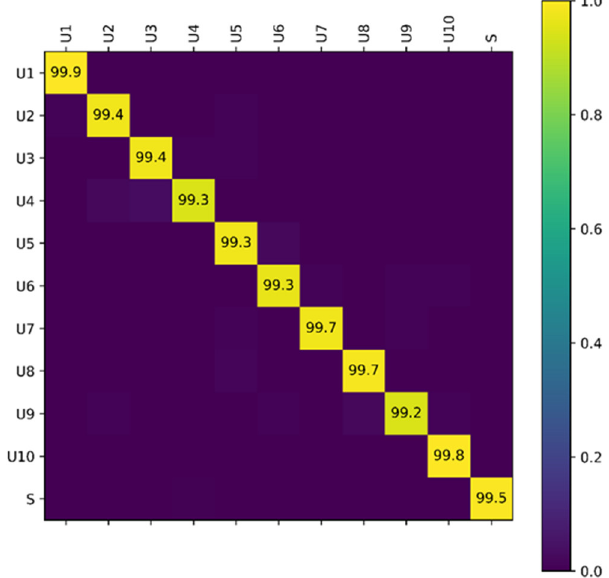
Figure 10. Confusion matrix of ArtiLock in the register stages.